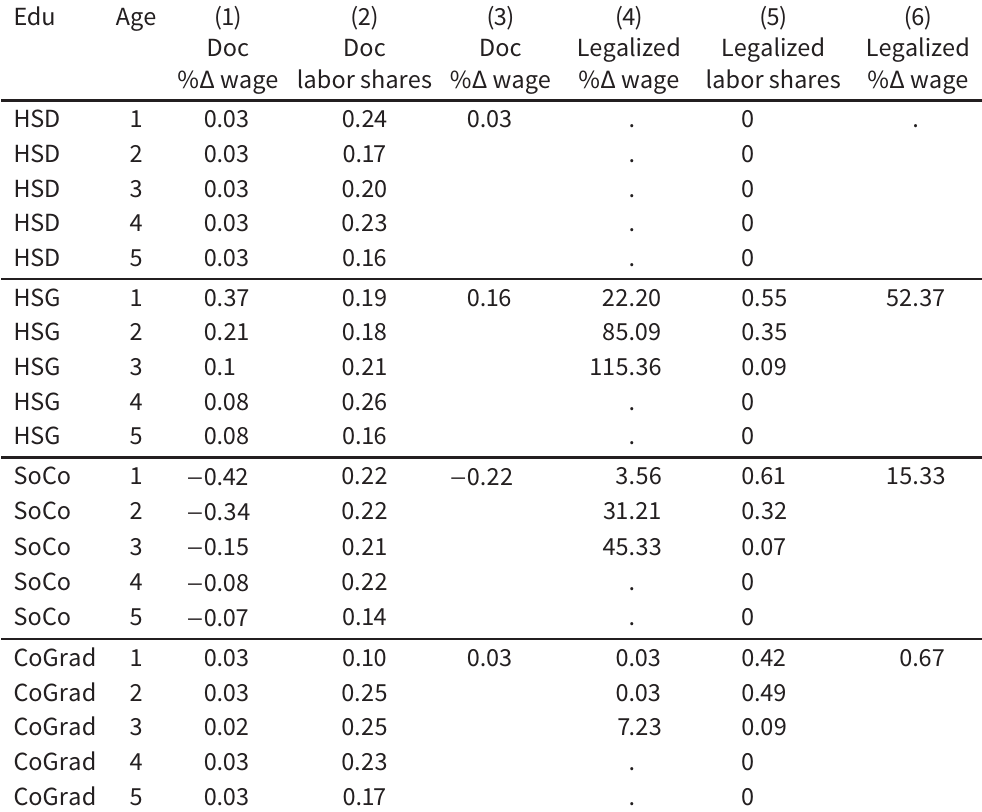
Wage Effects of DREAM Act. Percent Changes Relative to